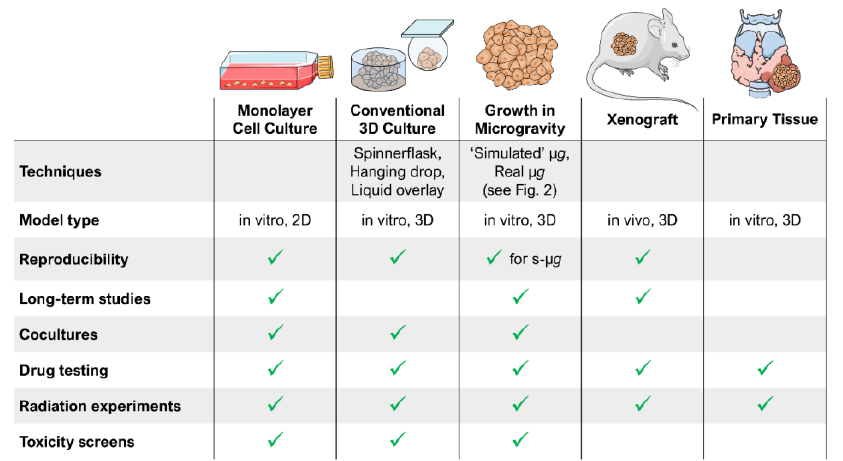
Figure 7. Comparison of different cell culture models for thyroid cancer research. s-µ g : simulated microgravity. Parts of the figure were drawn by using pictures from Servier Medical Art, licensed under